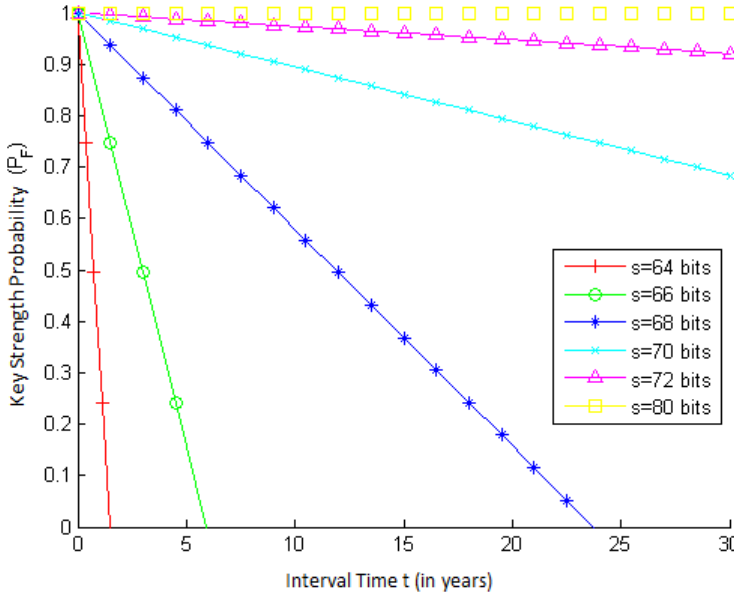
Figure 2. Key strength probability ( P rate f = 394 , 875 , 793 , 722